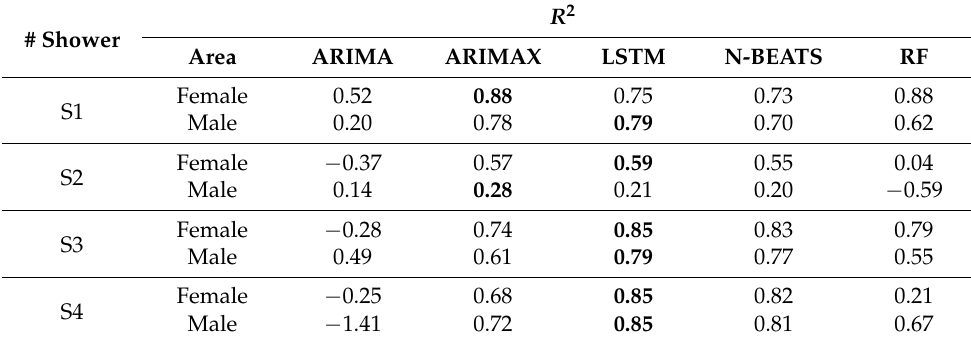
Table 8. Performance assessment with the models in terms of R 2 (bold indicates the best result for the corresponding shower room and gender).